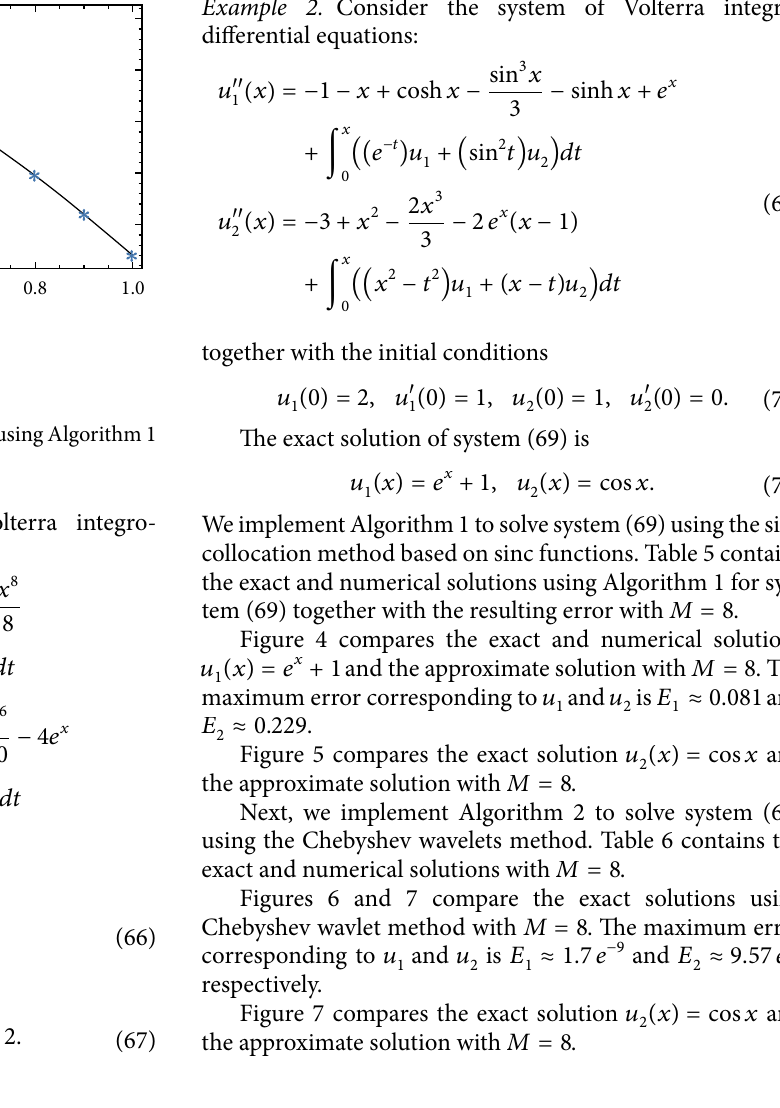
Figure 4: The exact and numerical solutions of for system (69).